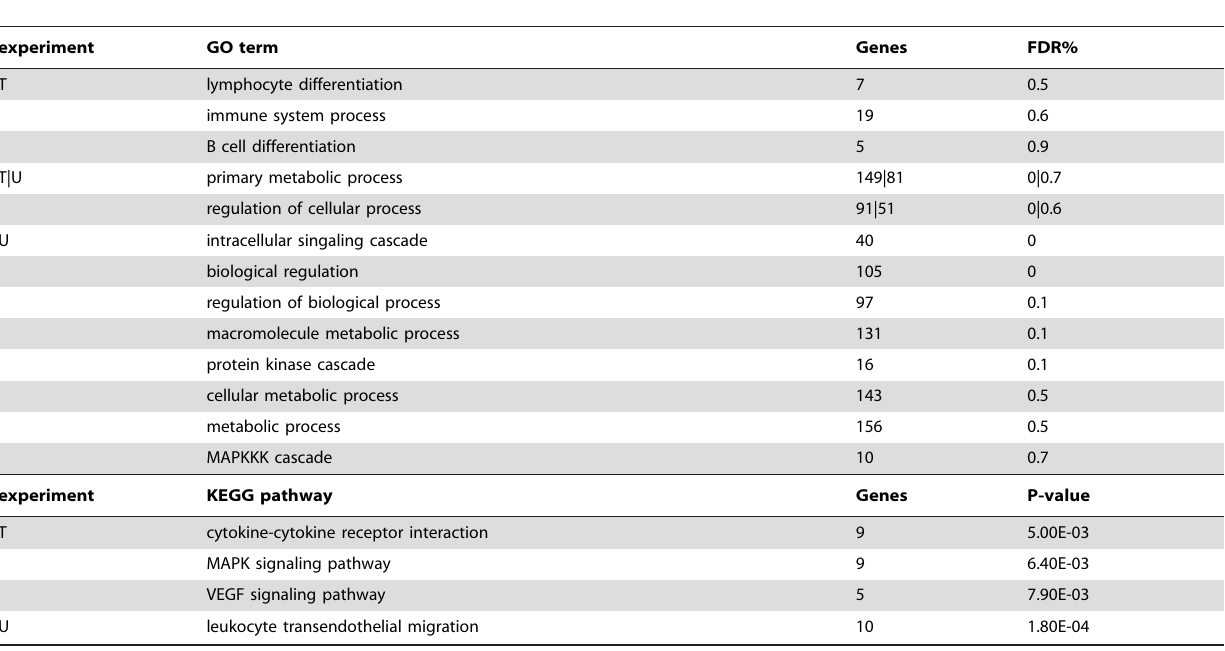
Table 2. GO (top) and KEGG pathway (bottom) analysis of RefSeq genes that are nearest lincRNAs.